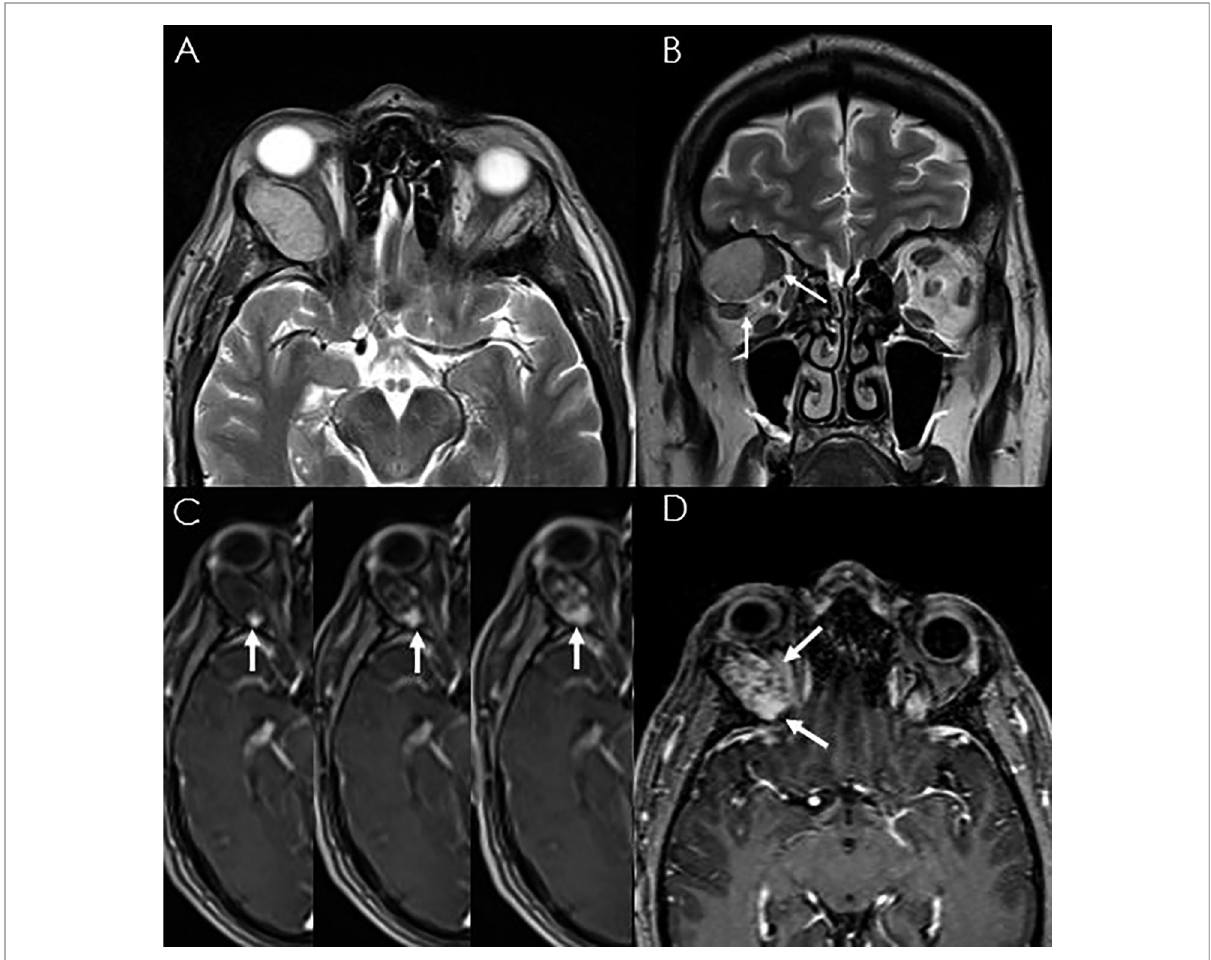
FIGURE 2 T2-weighted axial ( A ) and coronal ( B ) MRI showing the regular margin of the lesion displacing superior rectus and superior elevator palpebrae muscles medially and lateral rectus muscle inferiorly (thin arrows). Dynamic contrast-enhanced-MRI, the thick arrows indicate the progressive and centripetal enhancement after gadolinium administration ( C,D